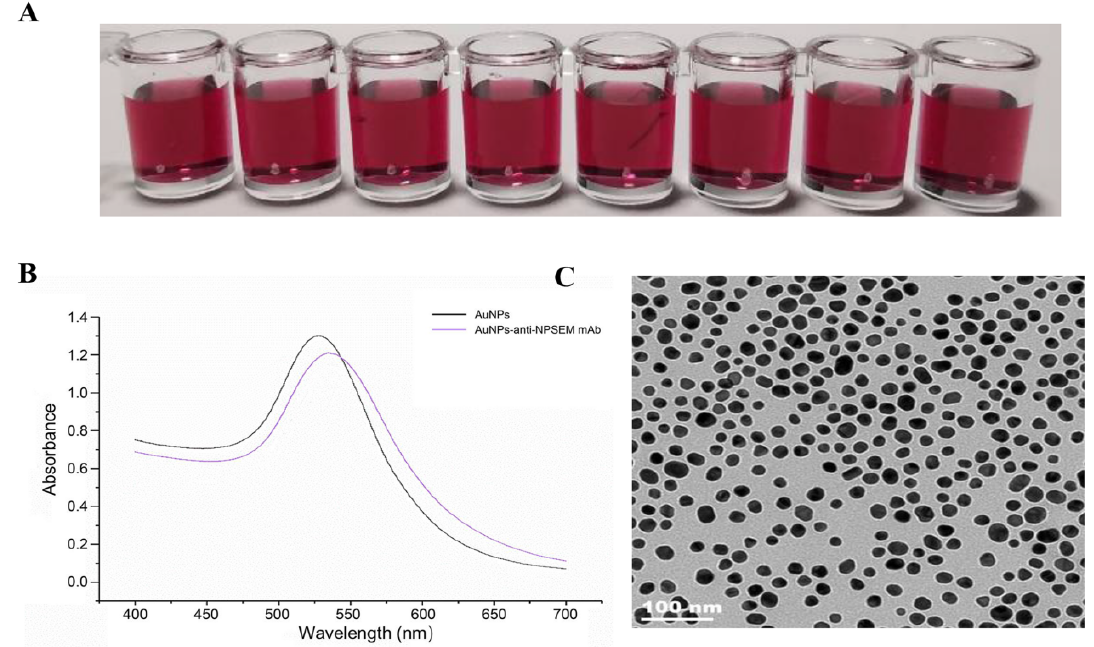
Figure 3. Identification of the prepared AuNPs. ( A ): AuNPs solution in eyes; ( B ): Visible absorption spectrum of naked AuNPs and AuNPs-anti-NPSEM mAb probe, whose concentrations were 4.0 nM and 1.3 mg mL − 1 , respectively; ( C ): Trans- mission electron micrograph of AuNPs.